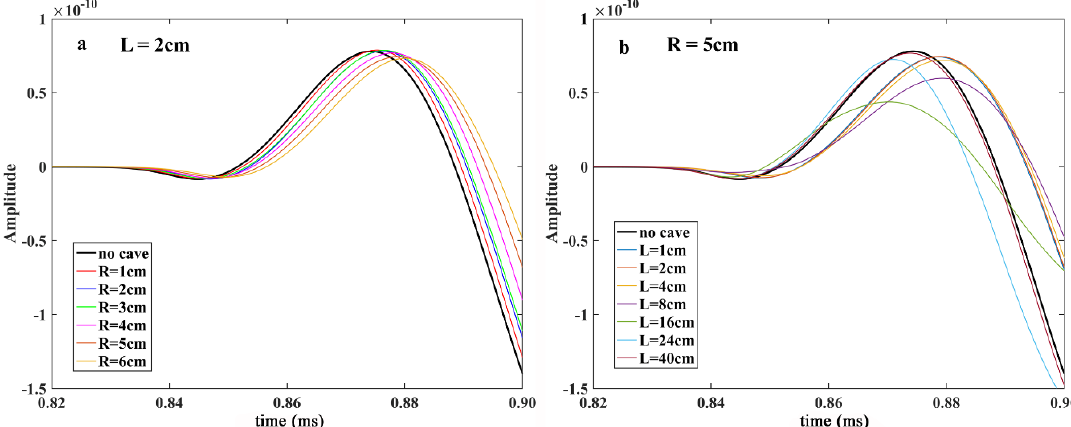
Figure 6. Effect of the cave on P-wave. ( a) shows the effect of the cave radius on P-wave. ( b) shows the effect of the cave position on P-wave. R represents the radius of the cave. L represents the distance of the cave to the borehole wall. Center frequency of source is 10 kHz. P-wave recorded by the receiver is 0.4 m above the cave.